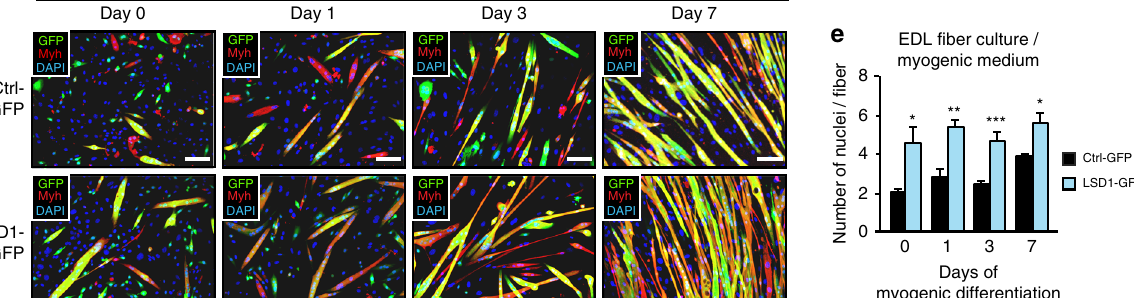
Myh3, Myh8 , and Myl1 compared to Ctrl-GFP myo fi bers